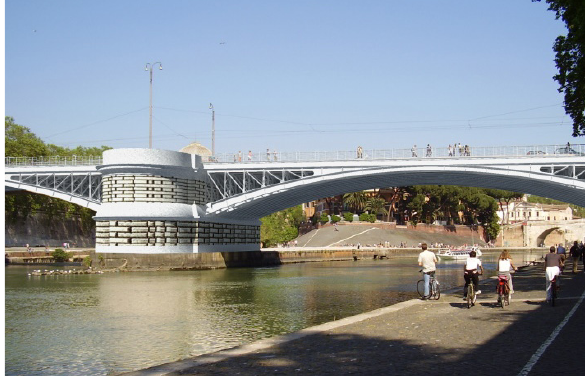
Figure 15. Virtual reconstruction of Alari Bridge placed near Castel